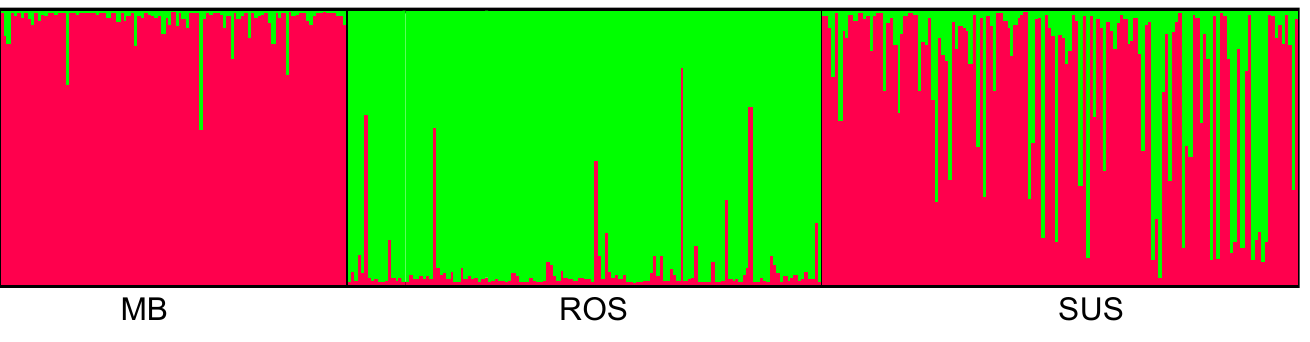
Figure 3. Clustering of B. humilis individuals from the MB, ROS, and SUS populations for K = 2 generated by STRUCTURE software.